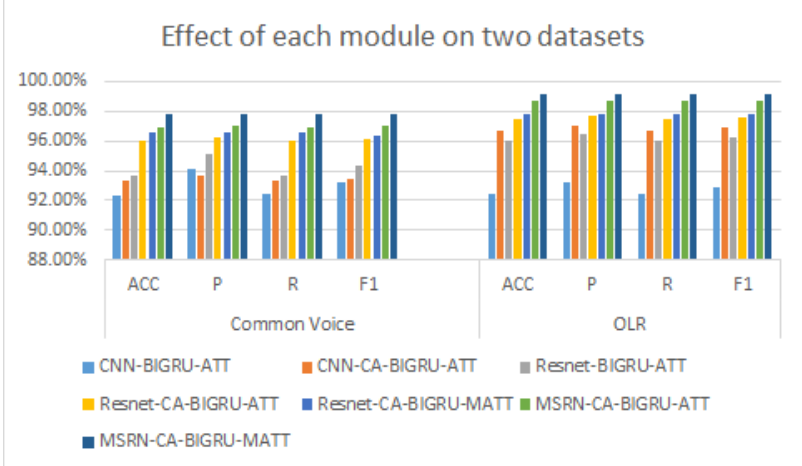
Figure 5. Effect of each module on the two